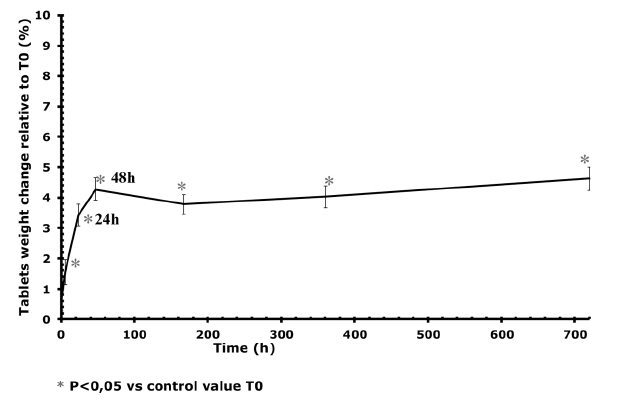
Fig. 3. Changes over time in the weight of tablets stored at 25 ˚ C/60% RH in comparison with T0. The vertical bars represent the 95% confidence interval limits for the measured weight